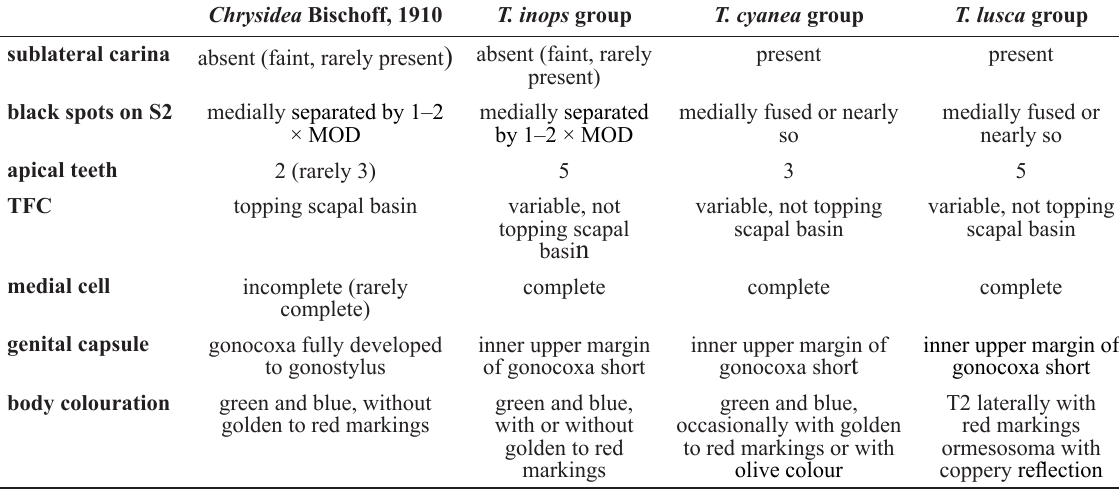
Table 1. Table summarising the main diagnostic differences between the species groups of Chrysidea Bischoff, 1910 and Trichrysis Lichtenstein,